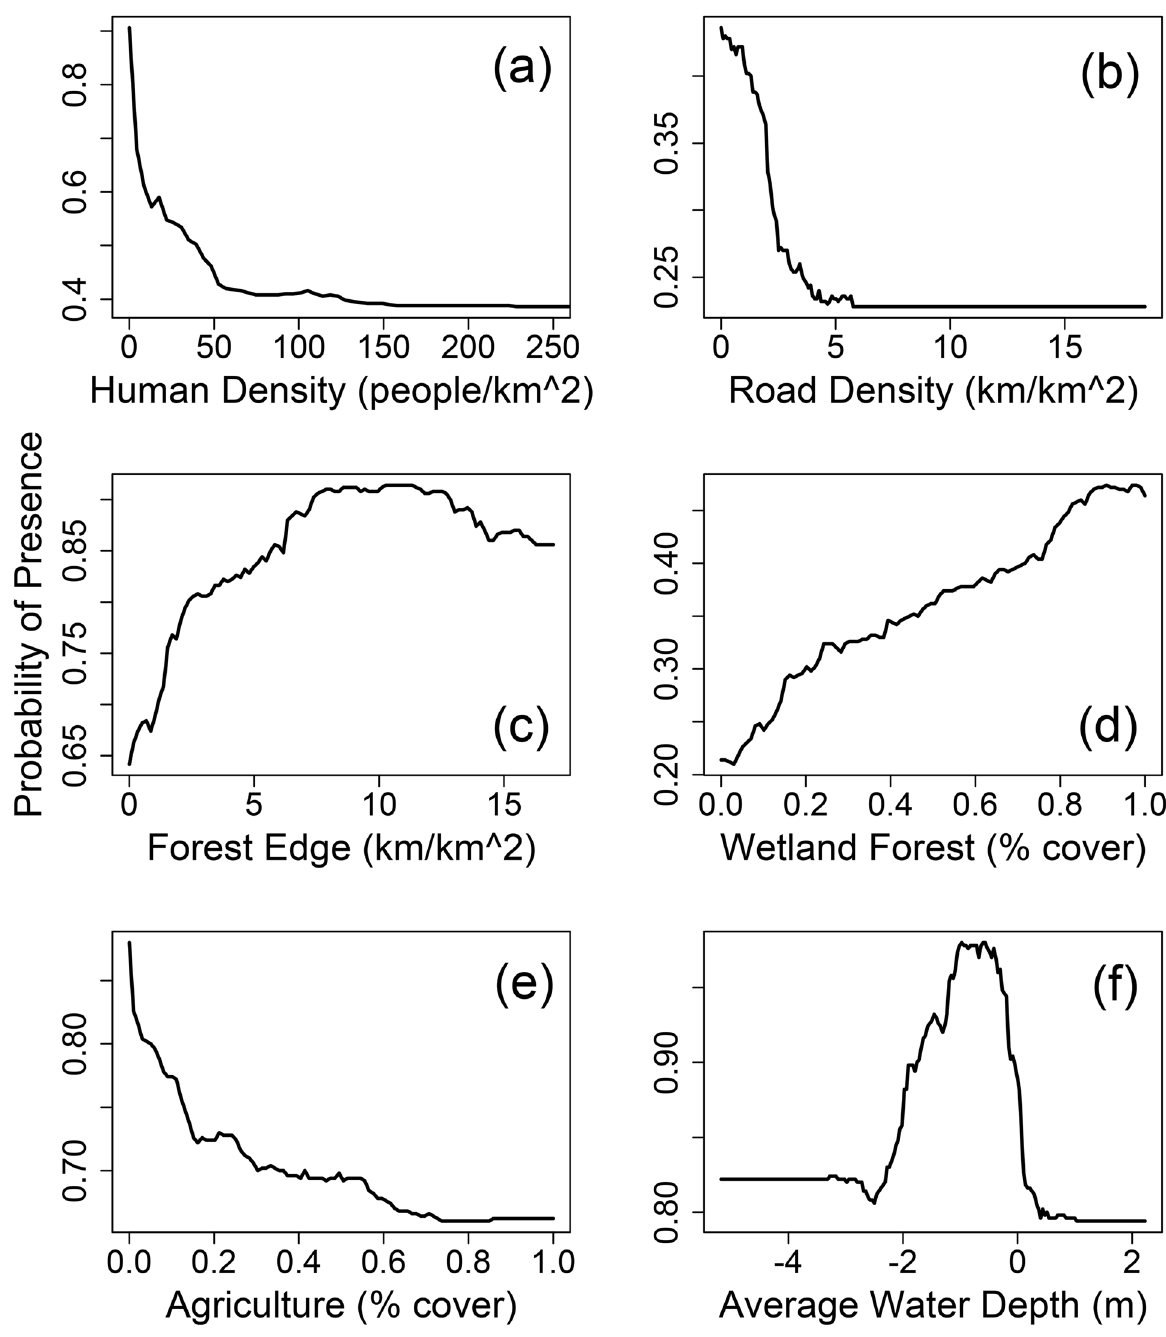
Fig 5. Sensitivity of model predictions (probability of presence, P ) to changes in selected explanatory variables. (a) human population density; (b) road density; (c) forest edge; (d) wetland forest cover; (e) agriculture (other than pasture); (f) average dry season water depth. The response to each variable was examined at high, medium and low ranges of P . The P range where the variable had its largest effect is shown.